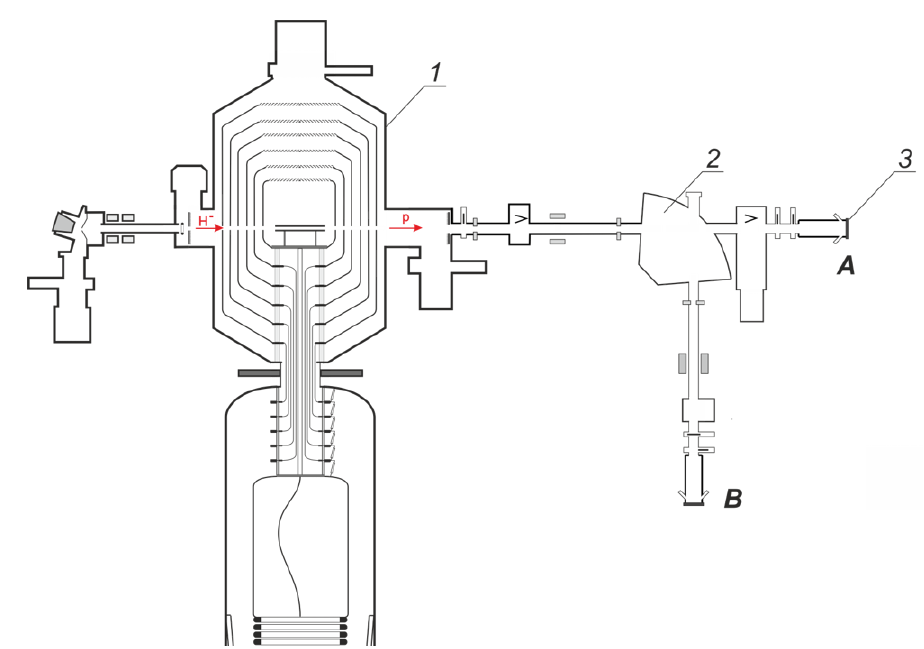
Figure 1. The layout of the experimental facility: 1 —vacuum insulated tandem accelerator, 2 — bending magnet, 3 —lithium target. A , B —lithium target placement